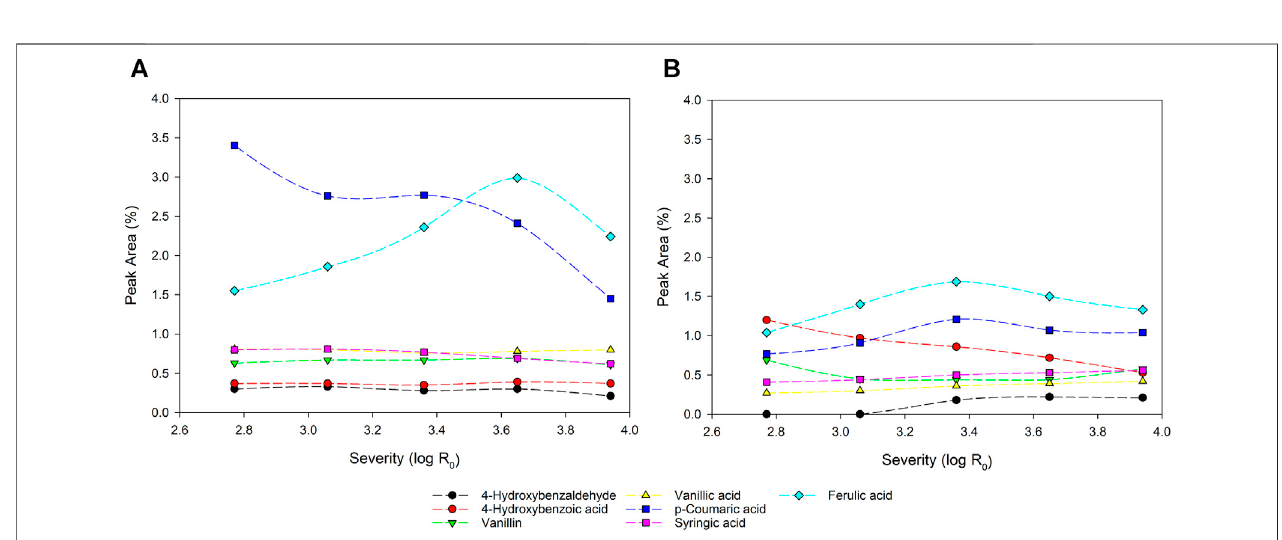
FIGURE 5 | Peak area % in GC/MS of the main phenolic compounds for CS (A) and MS (B) . The peak area is calculated as percentage based on the area of the whole chromatogram.